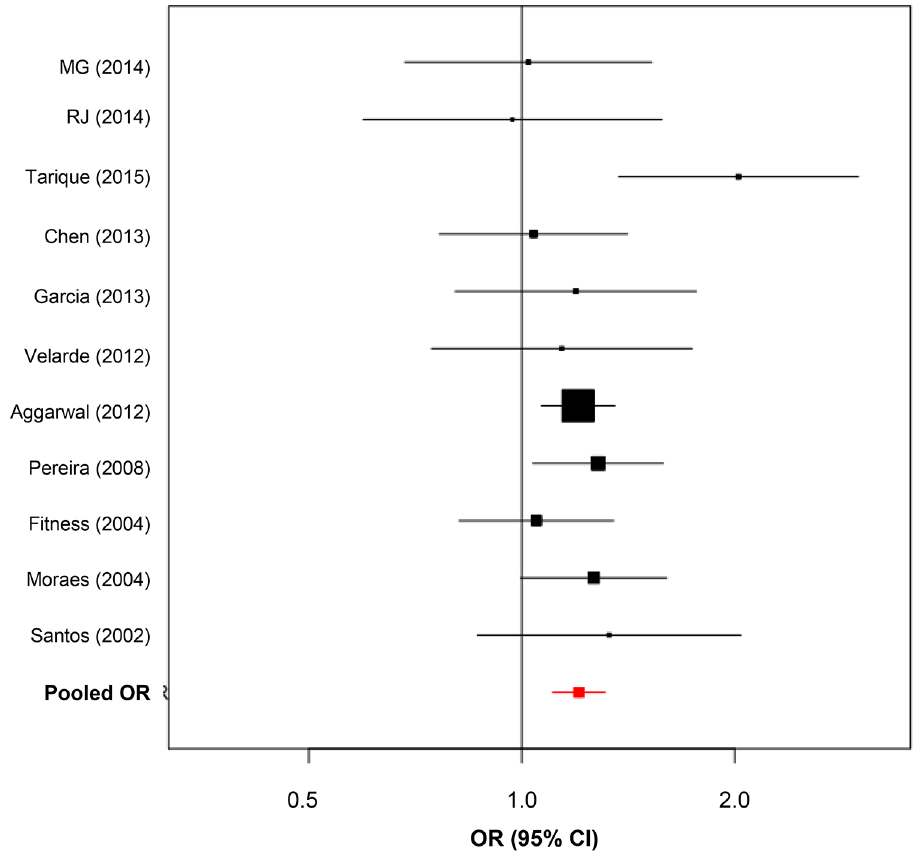
Fig 3. Forest plot for -819 C > T (rs1800871) including Brazilian Family-based data (MG and RJ). Bars represent 95% confidence interval and boxes represent OR values.